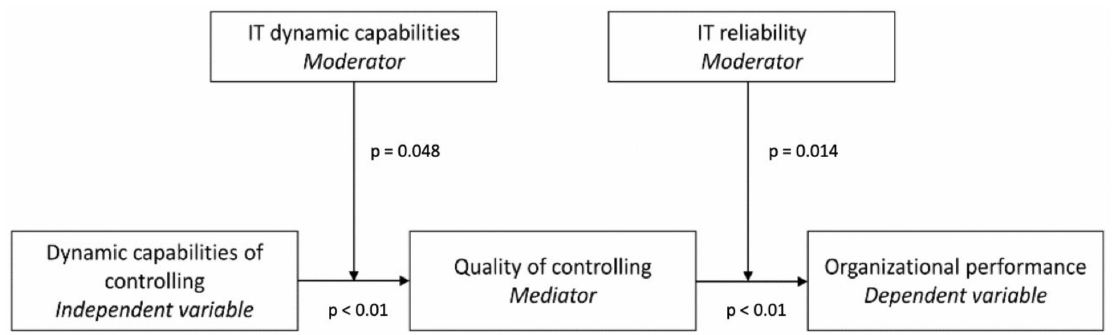
Figure 3. Empirical research results. Source: own